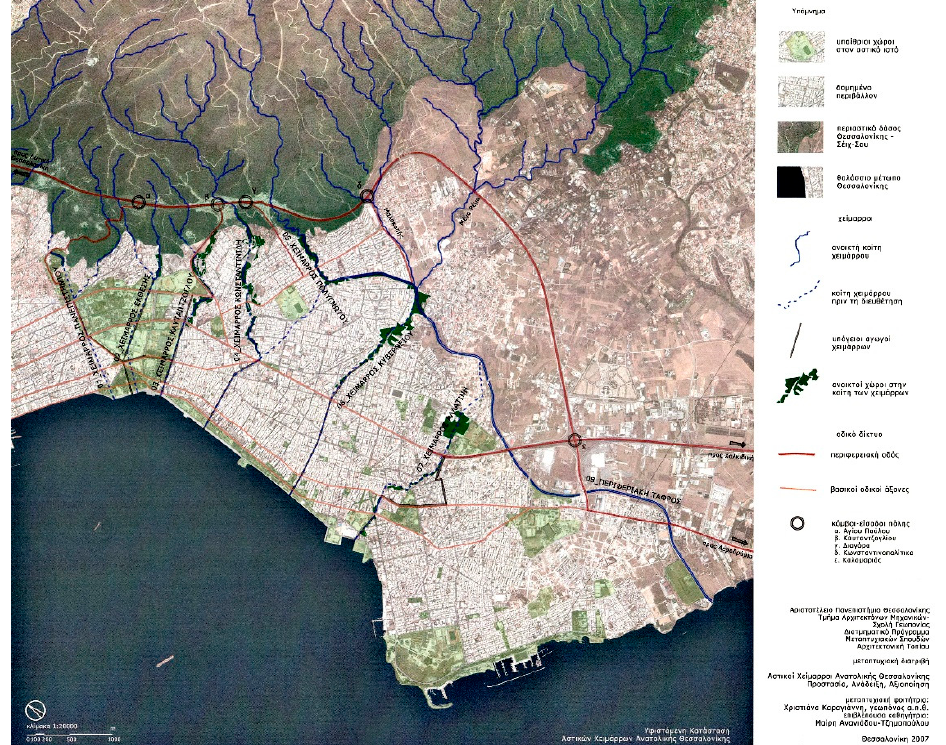
Figure 1. Urban streams of eastern Thessaloniki (In Greek) From left to right: Streams, ‘Panepistimiou’, ‘Ekthesi’, ‘Kaftanzoglou’, ‘Konstantinidi’, ‘Polygnotou’, ‘Kiverneiou’, ‘Allatini’. Starting as Polygnotou Stream and ending up all the way to the sea as the Peripheral moat of Thessaloniki. Source: Karagianni, C.;